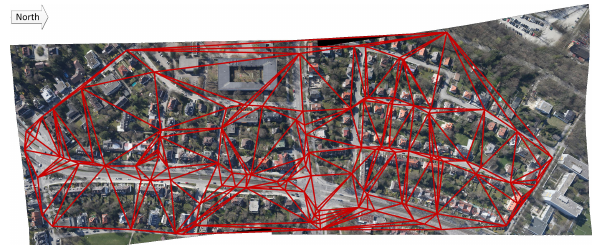
Figure 2. Delaunay triangulation of vehicle